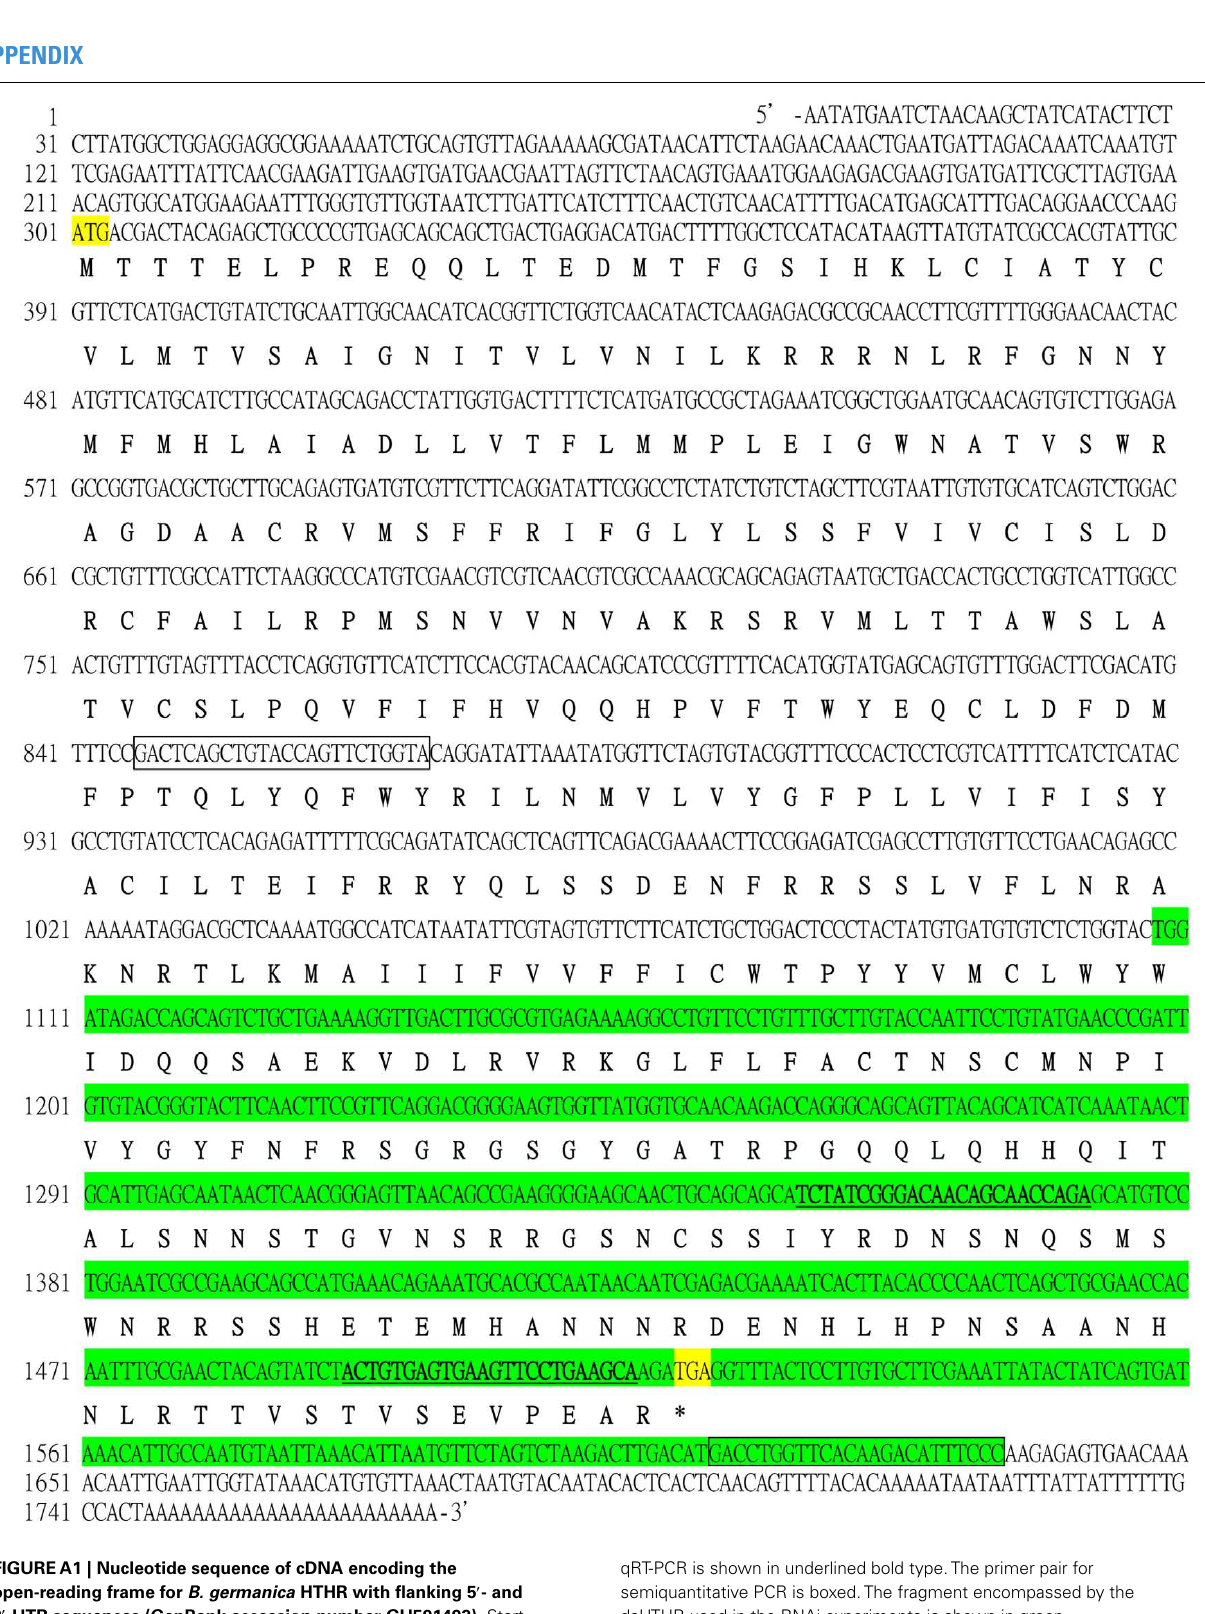
FIGUREA1 | Nucleotide sequence of cDNA encoding the open-reading frame for B. germanica HTHR with flanking 5 (cid:2) - and 3 (cid:2) -UTR sequences (GenBank accession number GU591493). Start and stop codon are indicated by yellow background.The primer pair for